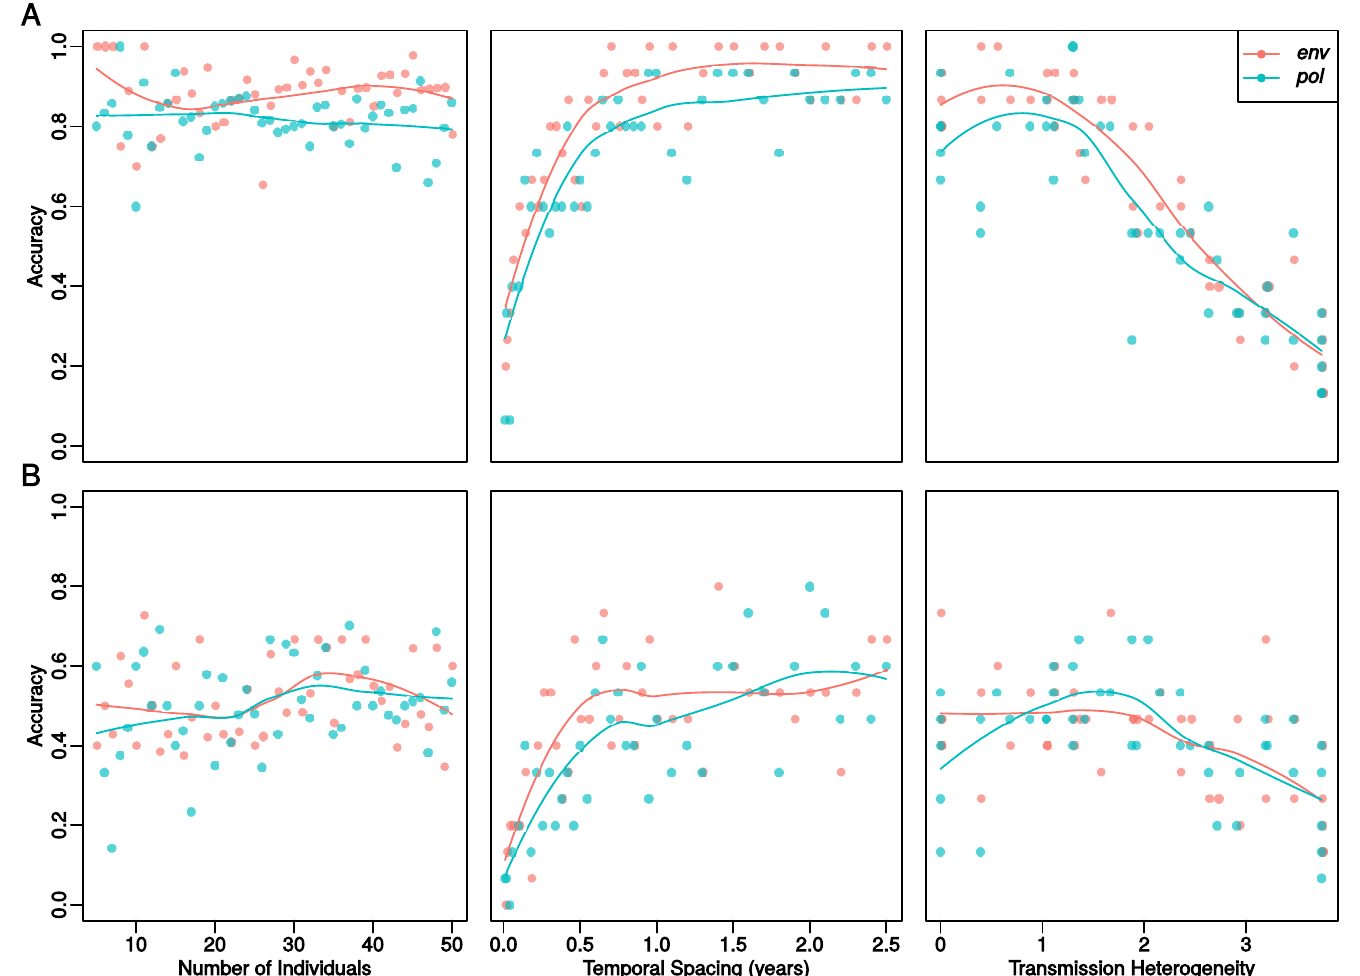
Fig 5. Individual Transmission Cluster Attribute Effects. Each point represents the accuracy of inference on a single transmission history, with the solid lines being the loess lines for each mutation model ( env or pol genomic regions). (A) The top row shows simulation results from idealized situations with complete transmission bottlenecks and low within host diversity ( α = 0 and β = 0.1), one year between infection and sampling, and fixed biomarkers. (B) The bottom row shows results from simulations with realistic HIV parameters in terms of transmission bottleneck size variation and within host diversity ( α = 5 and β = 5), two years between infection and sampling, and independent biomarkers. In each panel, the non-varied attributes used are 15 individuals, temporal spacing of 0.5 years, and transmission heterogeneity of about